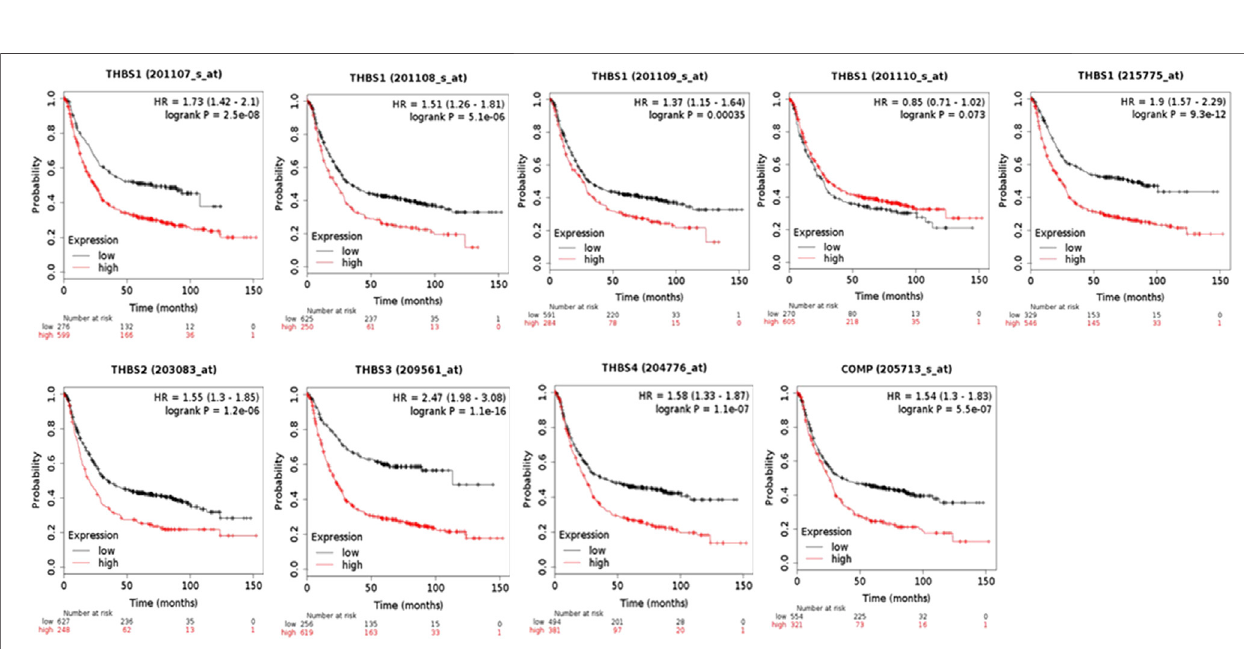
( Figure 1B ). The boxplot results in the GEPIA showed that the expression levels of THBS2 , THBS4 , and COMP were signi fi cantly higher in the GC tumor tissues than the normal tissues, while the expression levels of THBS1 and THBS3 were not signi fi cantly different ( Figure 1C ). Results from the UALCAN database also indicated that the expression levels of THBS1 were not signi fi cantly different between the tumor and normal tissues, while for other THBSs certain differences existed and which might also be associated with tumor stages ( Table 1 ).